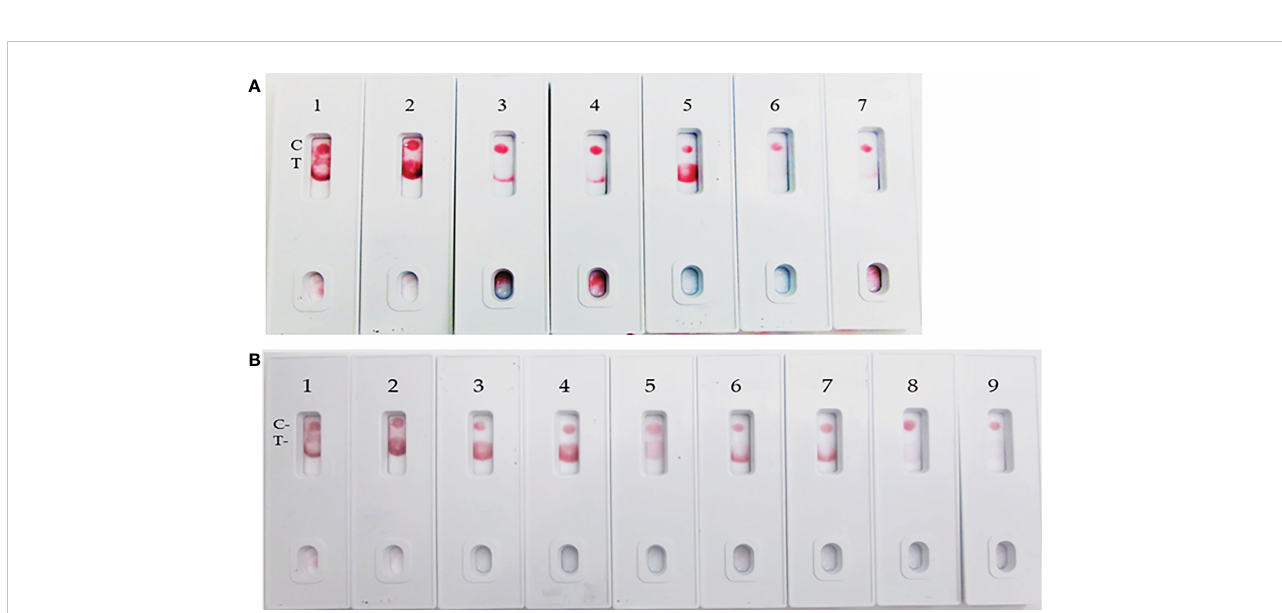
FIGURE 5 LFIA speci fi city with Coronavirus recombinant protein panel. (A) 1. NR-52397 SARS-CoV-2 spike protein (positive control), 2. NR-52366 SARS-CoV-2 RBD protein (positive control), 3. NR-52307 Spike RBD, Wuhan-Hu-1, Sf-9 insect cell produced-contains 223 residues of spike RBD, 4. NR-52946 Spike RBD from SARS-Related CoV-2 (HEK cell), 5. NR-52397 Full-length Spike protein-Wuhan-Hu-1 (stabilized), 6. NR-53713 Spike glycoprotein (stabilized), HKU1, 7. NR-53258 Vero E6 cell lysate (negative control). (B) 1. NR-52397 Spike protein (Stabilized) Coronavirus 2, (Wuhan-Hu-1) (positive control), 2. NR-52366 SARS-CoV-2 RBD protein (positive control), 3. NR-52397 Spike protein (Stabilized) Coronavirus 2, (Wuhan-Hu-1), 4. NR-53800 Spike Glycoprotein S2 Extracellular Domain (ECD) from SARS-CoV-2, 5. NR-53798 Spike Glycoprotein S1 Domain from SARS-CoV-2, 6. NR-52724 Spike protein from SARS-CoV-2 (S-2Pdfv), 7. NR-52946 Spike RBD from SARS-Related CoV-2 (HEK cell), 8. NR-53590 Spike Glycoprotein (Stabilized) from SARS Coronavirus, Tor-2 with C-Terminal, 9. NR-53258 Vero E6 cell lysate (negative